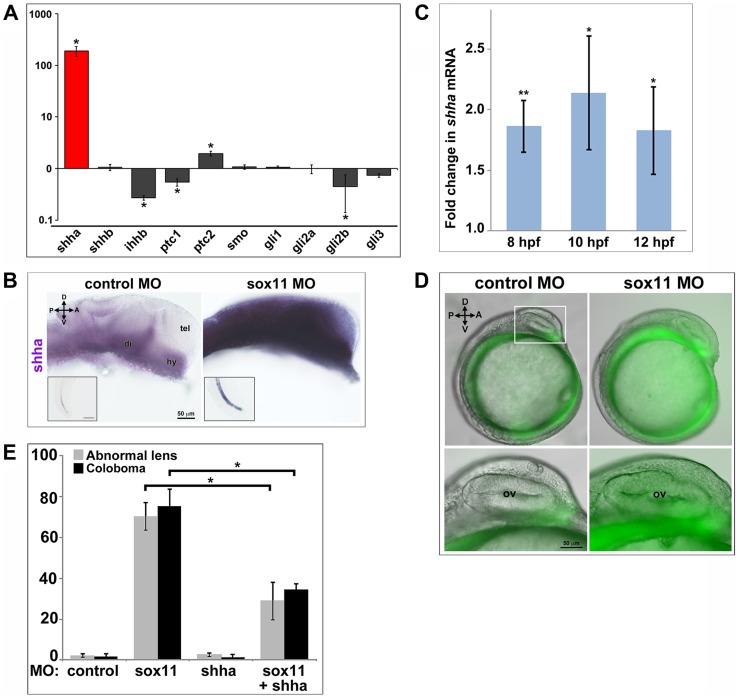

Shha expression is upregulated in sox11 morphants.(A) QPCR performed on mRNA from control and sox11 morphant heads at 24 hpf revealed a dramatic upregulation of shha expression, and a small but significant increase in ptc2 expression, in sox11 morphants compared to controls (n = 70 embryos per group, 3 independent biological replicates). Relative transcript abundance was normalized to gapdh levels. The Y-axis (log-scale) represents the mean ratio of sox11 morphant to control expression for three biological and three technical replicates. *p<0.01, Student's t-test. (B) In situ hybridization with a shha probe on control (left) and sox11 morphant (right) embryos at 24 hpf revealed expanded shha expression in sox11 morphants throughout the brain and also in the notochord (inset). Numbers of embryos analyzed: n = 15 embryos per group, 3 independent repeats. (C) QPCR performed on mRNA from control and sox11 morphant heads at 8, 10 and 12 hpf demonstrated an upregulation of shha expression in sox11 morphants compared to controls. Relative transcript abundance was normalized to gapdh levels and is presented as the mean fold-change in expression relative to controls (n = 60 embryos per group, 3 independent biological repeats). **p<0.001, *p = 0.01, Student's t-test. (D) Sox11 morphants (right) on the ptc2:EGFP background displayed elevated GFP expression in the midline at 12 hpf compared to control morphants (left). The bottom panels are an enlargement of the boxed area indicated in the top left panel. Number of embryos analyzed: control MO, n = 34; sox11 MO, n = 41, 3 independent biological replicates. (E) Co-knockdown of shha and sox11 reduced the proportion of embryos displaying abnormal lens and coloboma phenotypes at 24 hpf and 2 dpf, respectively. Number of embryos analyzed: 24 hpf control MO, n = 186; 2 dpf control MO, n = 165; 24 hpf sox11 MO, n = 199, 2 dpf sox11 MO, n = 182; 24 hpf shha MO, n = 249; 2 dpf shha MO, n = 231; 24 hpf sox11+ shha MO, n = 207; 2 dpf sox11+ shha MO, n = 190; 3 independent biological replicates. *p<0.0001, Student's t-test. D, dorsal; V, ventral; A, anterior; P, posterior; hpf, hours post fertilization; dpf, days post fertilization; R, retina; di; diencephalon, tel, telencephalon; hy, hypothalamus; MO, morpholino.